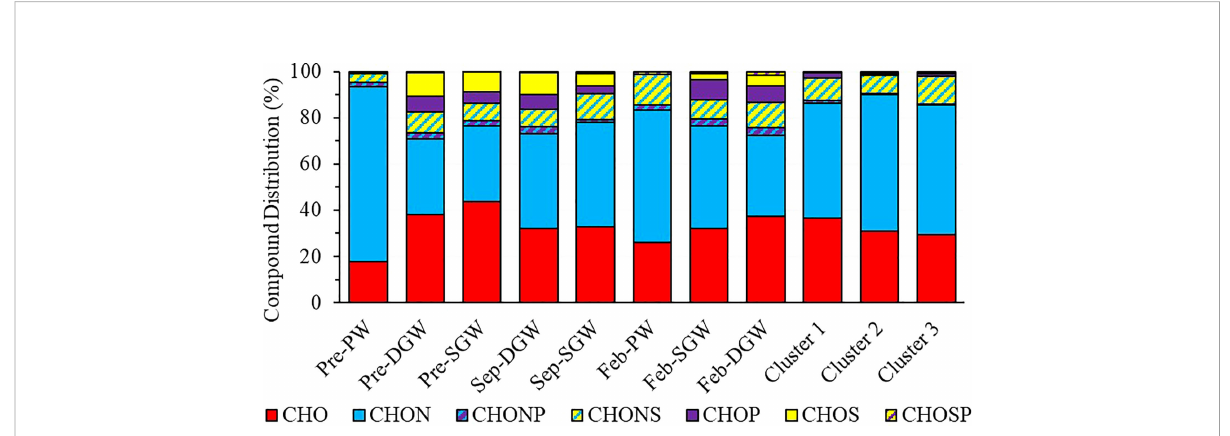
FIGURE 6 DOM molecular composition and percent presence with assigned formulas for pre- and post-landfall (September and February), porewater (PW), and shallow (SGW) and deeper (DGW) groundwater. DOM, dissolved organic